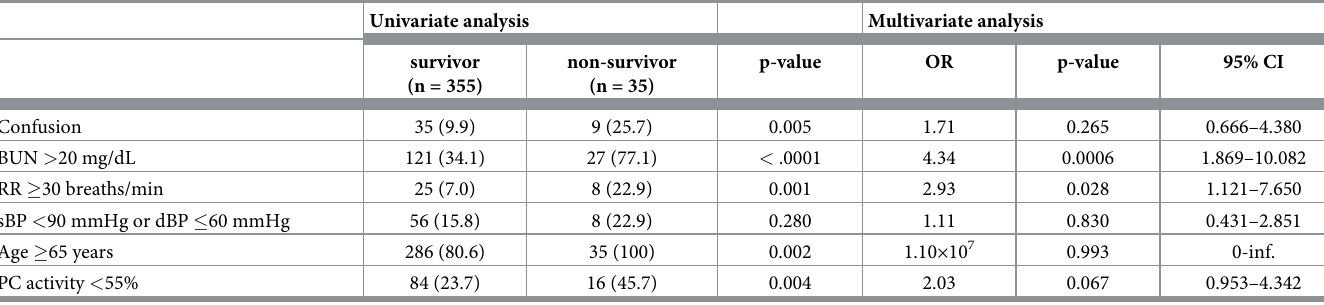
Table 5. Examination of prognostic factors using logistic analysis in